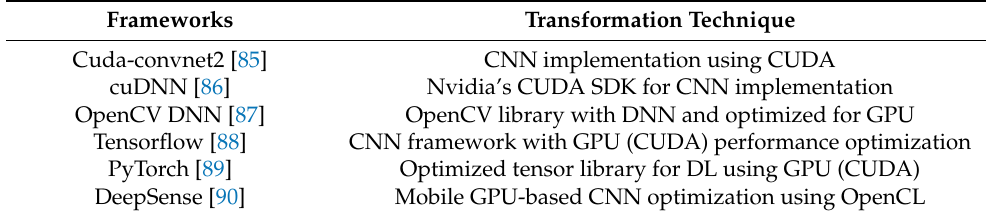
Table 2. Available frameworks for GPUs.